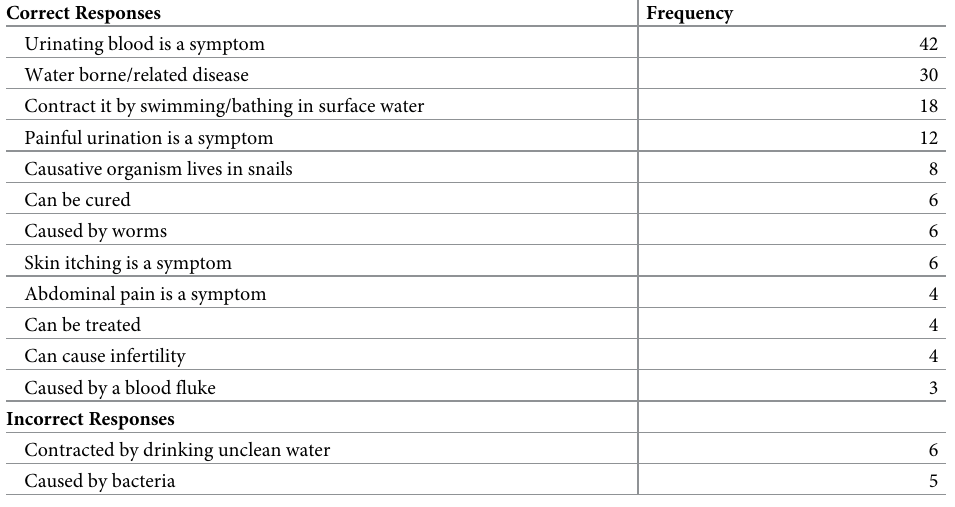
Table 2. The most common correct and incorrect responses to a listing question asking teachers for 5 facts about